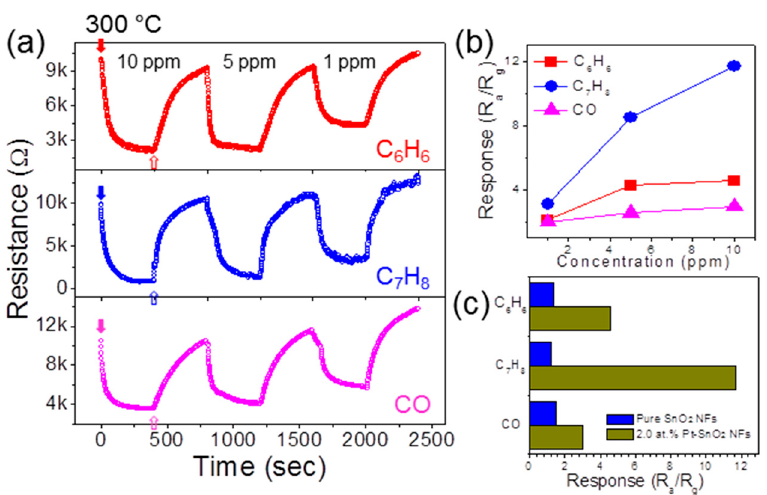
Figure 7. ( a ) Resistance curves of 2.0 at.% Pt-functionalized SnO 2 NFs for other reducing gases at 300 ◦ C; ( b ) Summarized responses; ( c ) Comparison of the responses of 2.0 at.% Pt-functionalized SnO